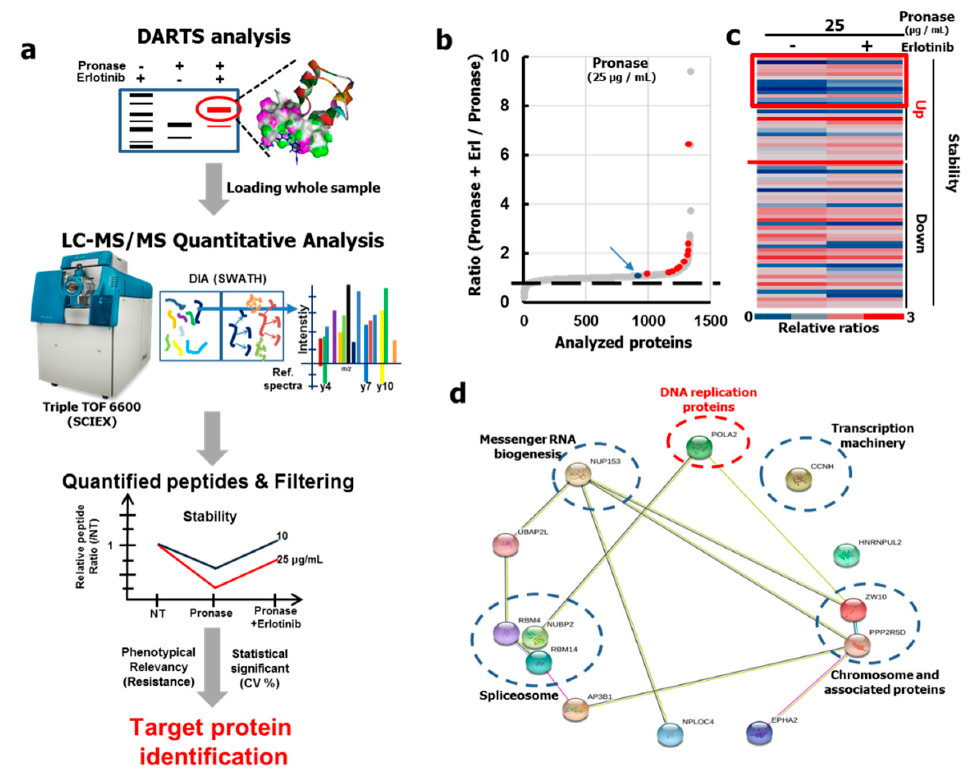
Figure 2. DARTS LC-MS / MS proteome analysis with Erlotinib-treated proteomics using H1299 cell lysates, identifying new Erlotinib binding proteins, responsible for Erlotinib-resistance in H1299 cells. ( a ) Process for the identification of new Erlotinib binding proteins by DARTS LC-MS / MS; ( b ) Identified proteins were analyzed by the averaged quantitative SWATH analysis data from the DARTS sample (pronase 25 µ g / mL). A blue dot with an arrow shows EGFR protein, an Erlotinib known target, and red dots are corresponding proteins in Figure S2d. The dashed line is 1 (normalized ratio), which demonstrates the stabilized proteins after Erlotinib treatment; ( c ) The heatmap exhibits relative ratios compared to NT in proteins after pronase treatment with or without Erlotinib. Proteins with ratios greater than 1 were grouped into stability up. The red box area indicates the top 20% of total proteins identified in this study (see Table S2); ( d ) The results of KEGG mapping and STRING